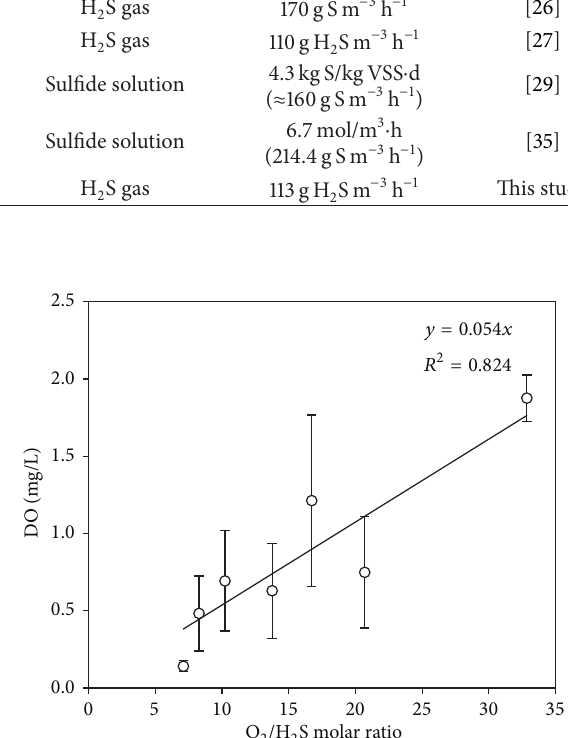
Figure 5: Correlation between O 2 /H 2 S molar ratio and